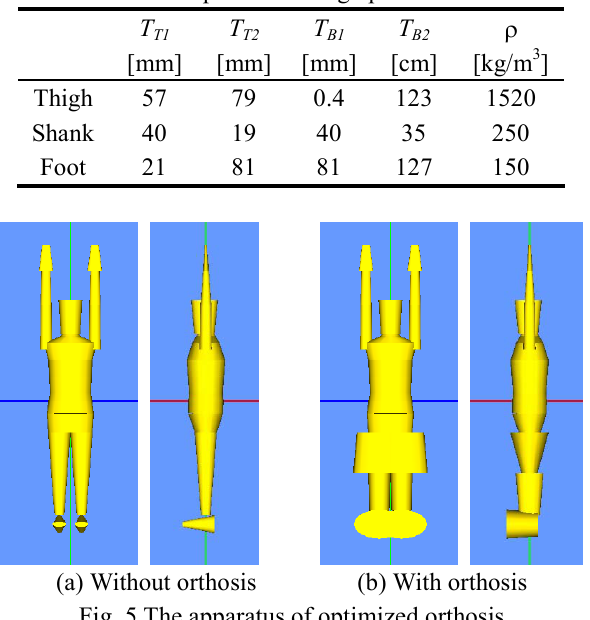
Fig. 5 The apparatus of optimized orthosis The time histories of the muscle forces of the RF and VM in the right leg are shown in Fig. 6. The time t is normalized by the walking cycle. The moment t = 0 (and t = 1) is the heel contact. The period t = 0 – 0.6 is the stance phase, and t = 0.6 – 1 is the swing phase. By attaching the orthosis, the RF muscle force became 5 times larger at the peak and the VM muscle force became 9 times larger than that of without orthosis. Therefore, it can be said that the knee extensors could be actively exerted by attaching the orthosis.